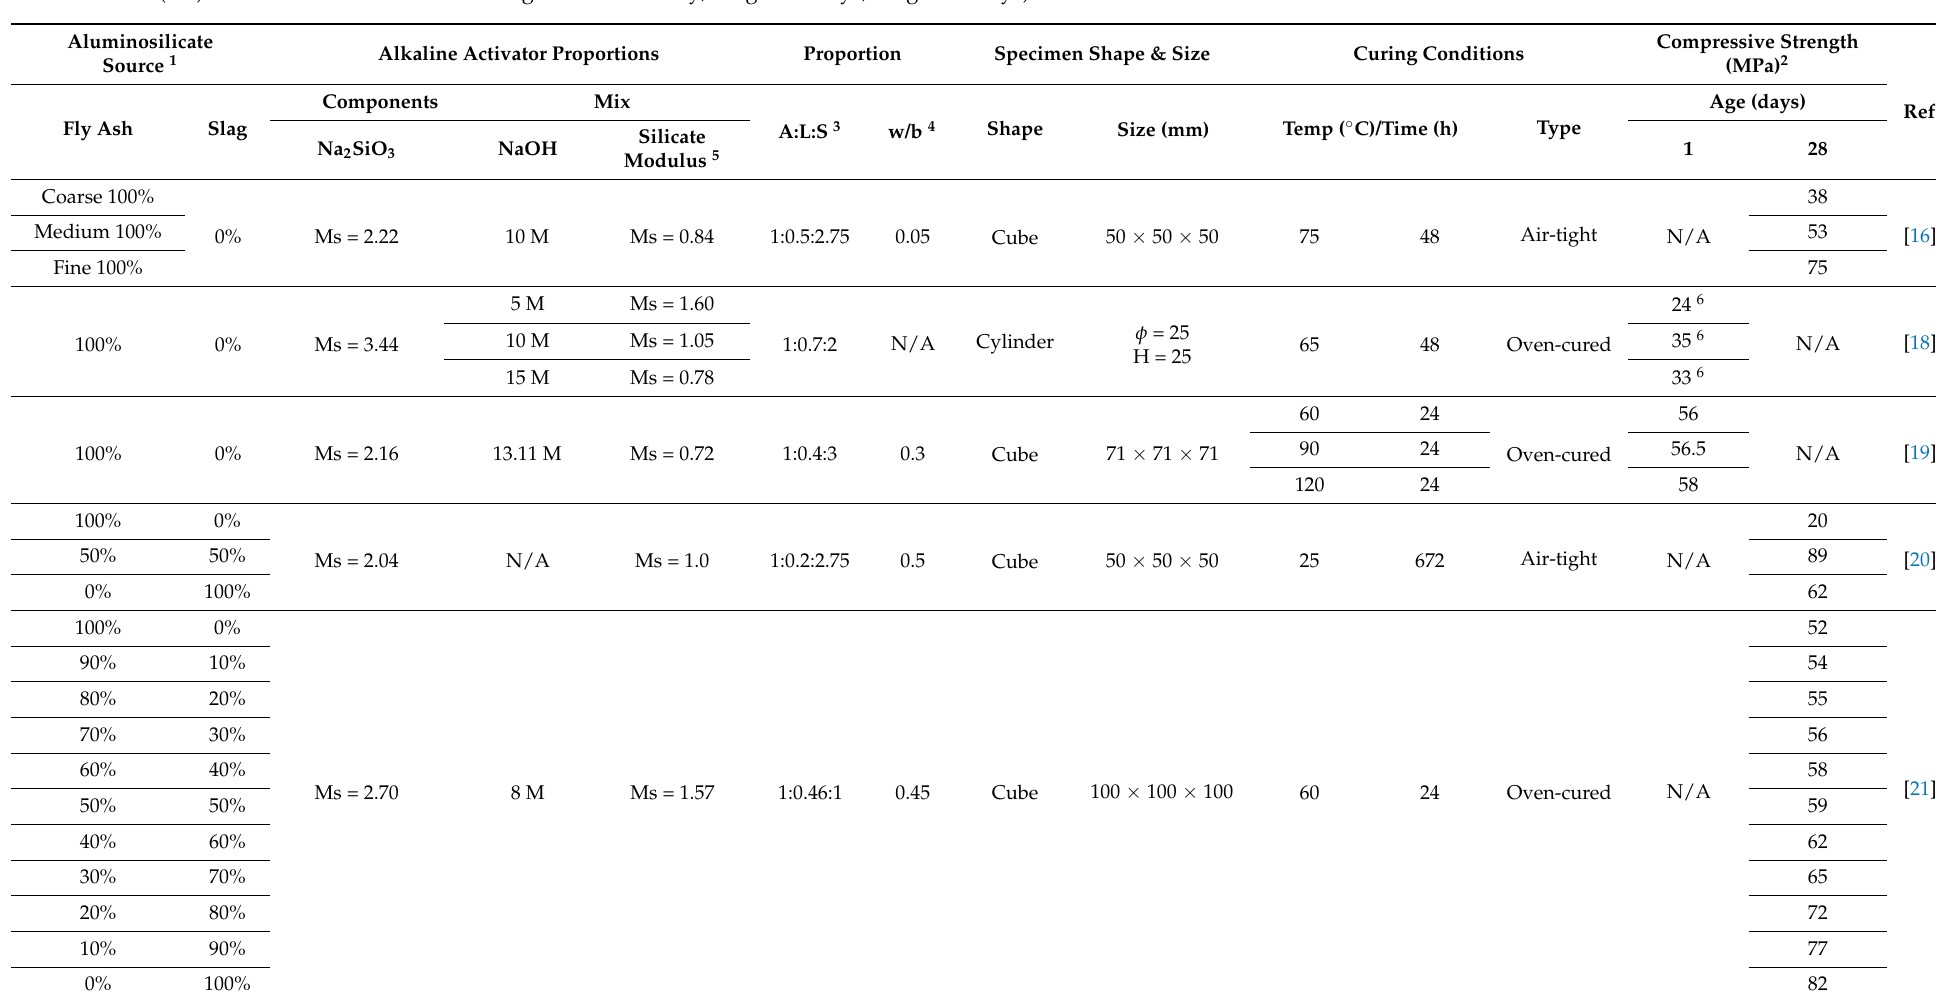
Table 1. Comprehensive summary of geopolymer mortars cured at high temperatures ( 1 Percentages are wt%; 2 Some compressive strength values have been approximated from the graphical representations; 3 A:L:S = Aluminosilicate (fly ash + slag): Liquid alkaline activator (Na 2 SiO 3 + NaOH): Sand ratio by mass; 4 w/b = water/binder ratio by mass; 5 Final silicate modulus (Ms) was calculated from mass ratio given in the study; 6 Age at 2 days; 7 Age at 7